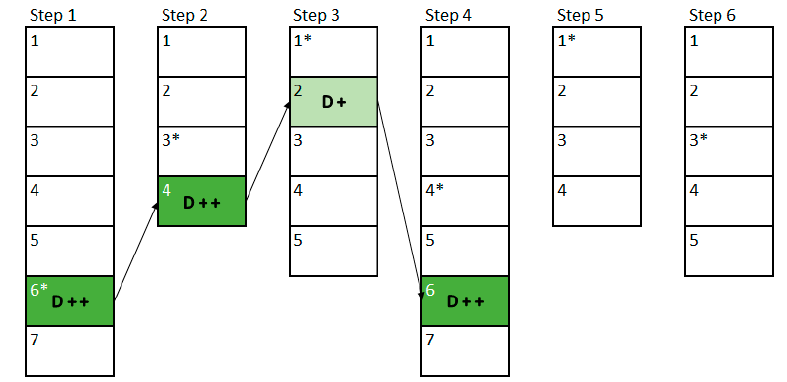
Figure 14. Example of the second execution of a program and modification of the difficulty performed